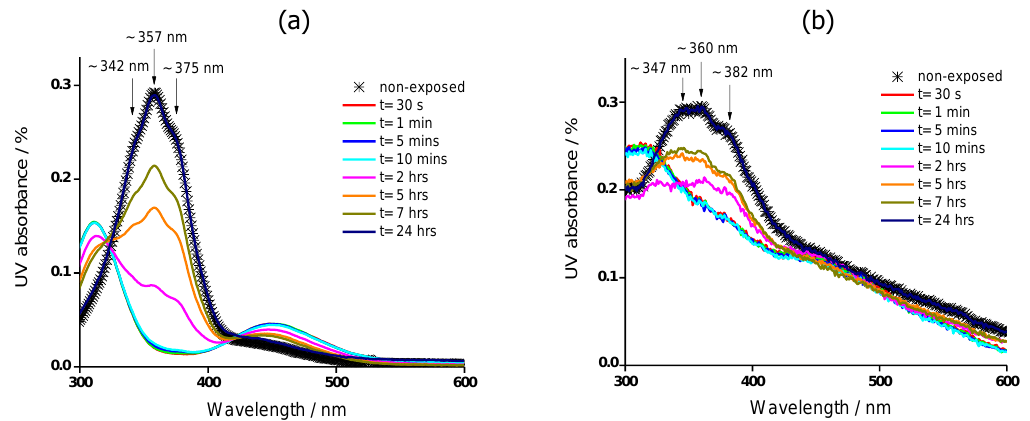
Figure 7. UV-visible spectra of PA-b-PS-b-PM, measured at room temperature, obtained for a: ( a ) 3.73 10 − 5 M THF solution; ( b ) film cast on a quartz substrate. Crosses correspond to the original spectrum prior to UV exposure (non-exposed), and dotted arrows indicate the cis- to -trans thermal relaxation with time, t , after exposure, while keeping the samples in the dark. Solid arrows indicate contributions of non-aggregated (~357/360 nm) and aggregated (~342/347 and ~375/382 nm) azobenzenes.